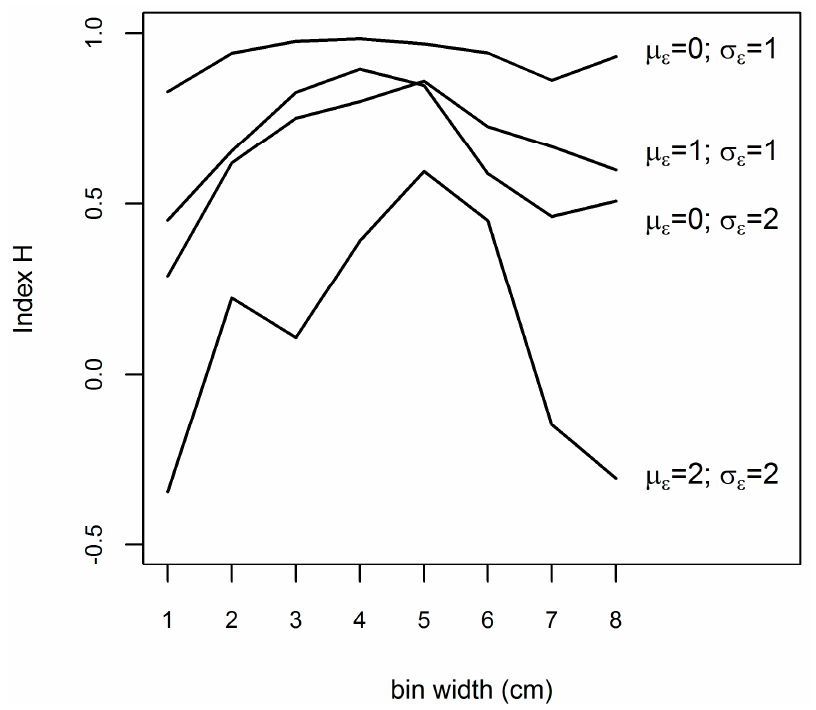
Figure 5. Effect of bin width on index H values for different combinations of mean and standard deviation values.